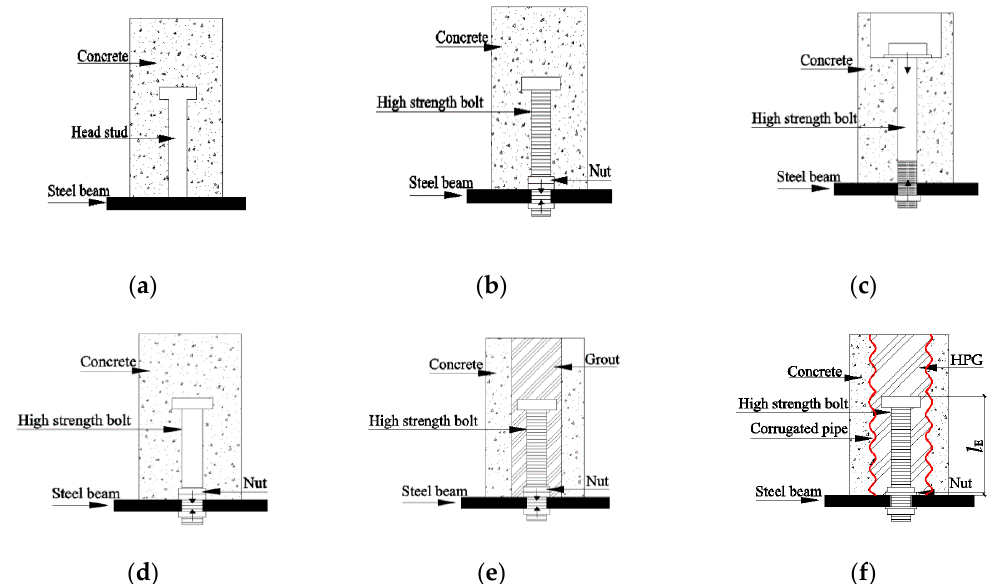
Figure 1. Welded headed stud and different types of bolt shear connectors: ( a ) headed stud; ( b ) Type 1; ( c ) Type 2; ( d ) Type 3; ( e ) Type 4; ( f ) Type 5.